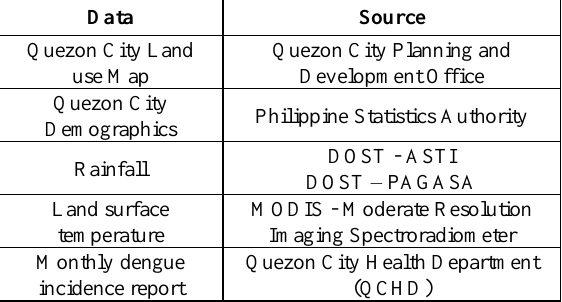
Table 1. List of all data gathered and their sources.